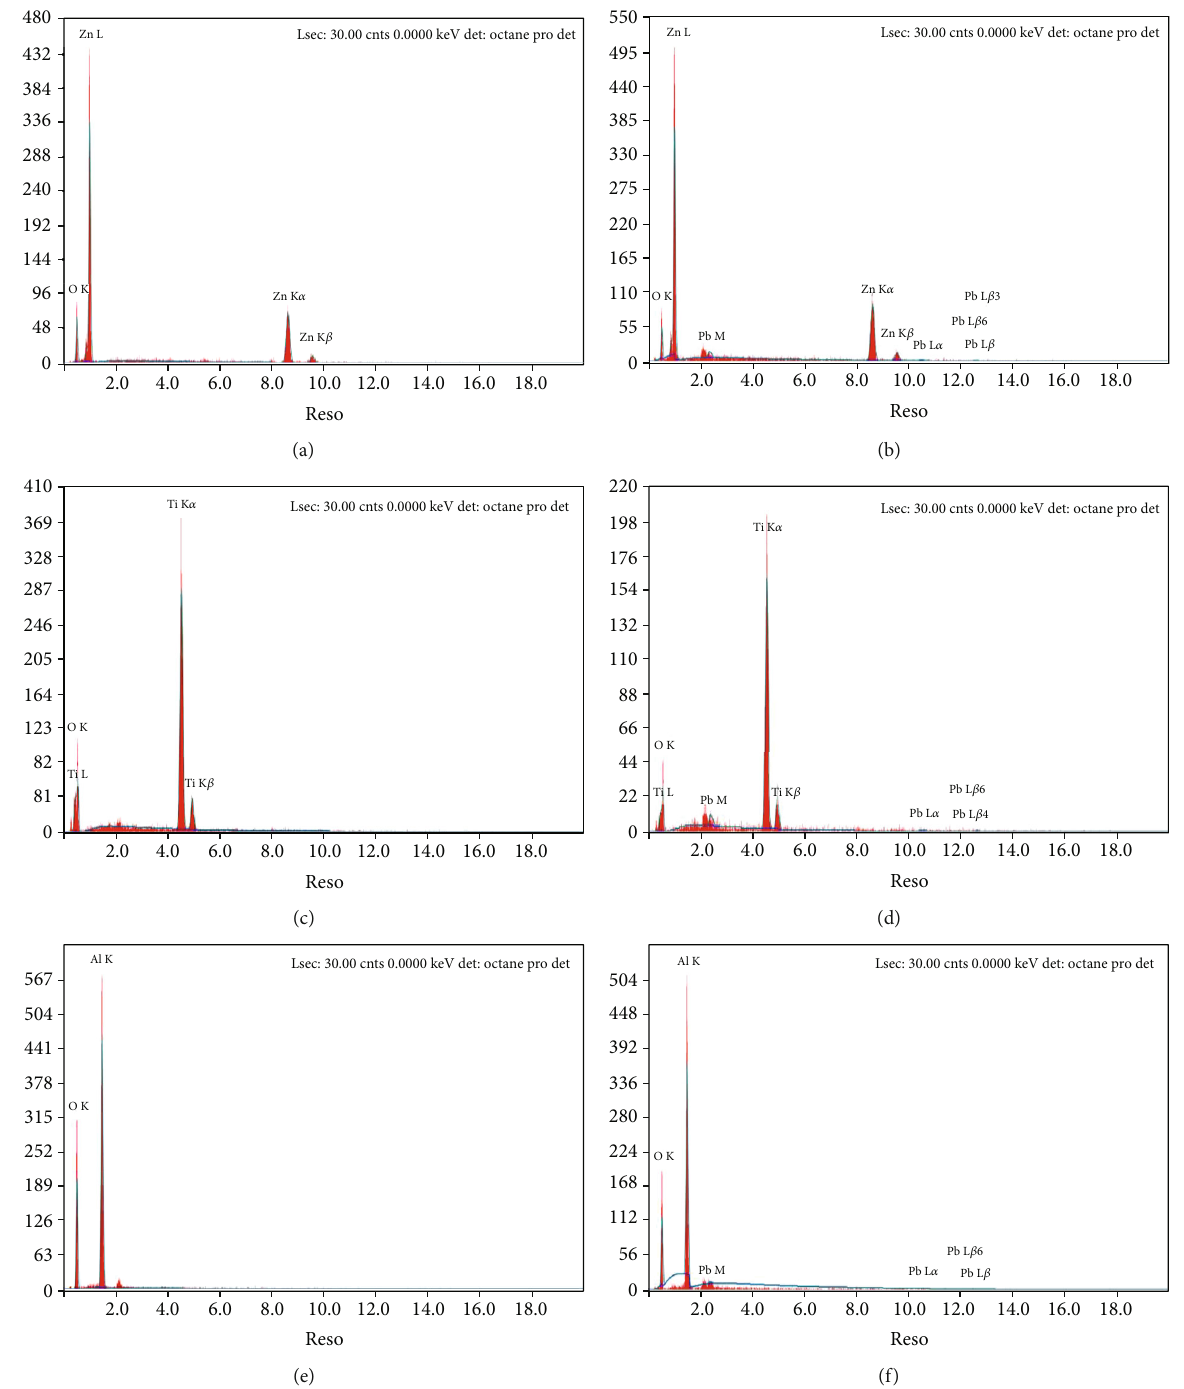
Figure 9: EDX pattern: (a) unloaded ZnO, (b) loaded ZnO, (c) unloaded TiO di ff erent magni fi cation scales reveals a clear change in the morphology and emphasizes that adsorption occurred.